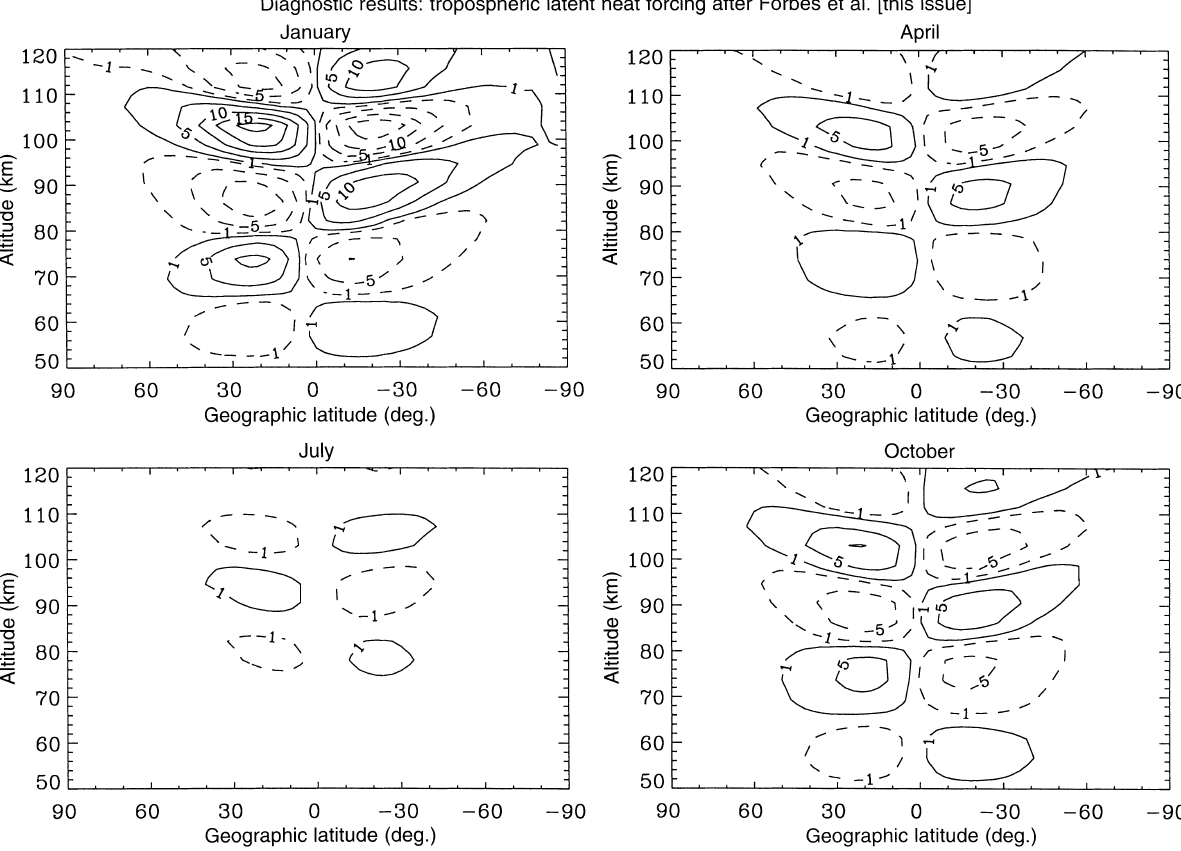
Fig. 6. The migrating GSWM diurnal northward wind response at 12 LST versus latitude and altitude (km) during January ( upper left ), April ( upper right ), July ( bottom left ), and October ( bottom right